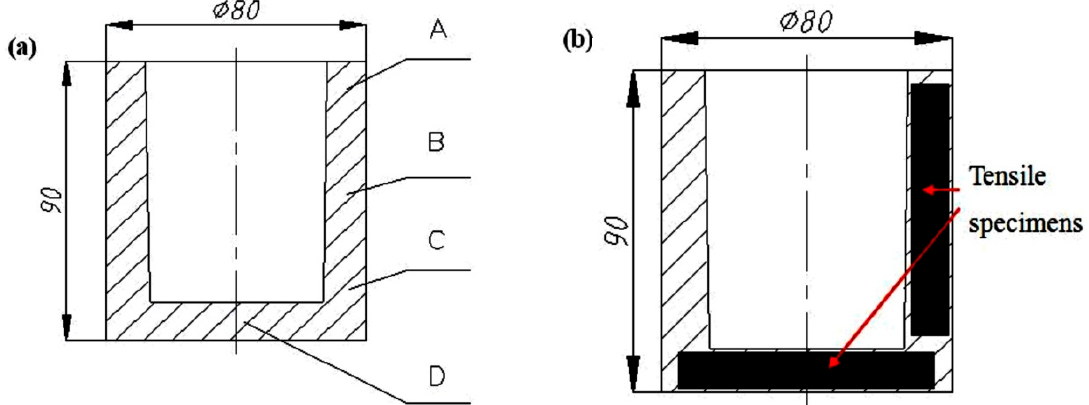
Figure 2. Sampling schematic diagram of the ( a ) microstructural specimens and ( b ) the tensile specimens.